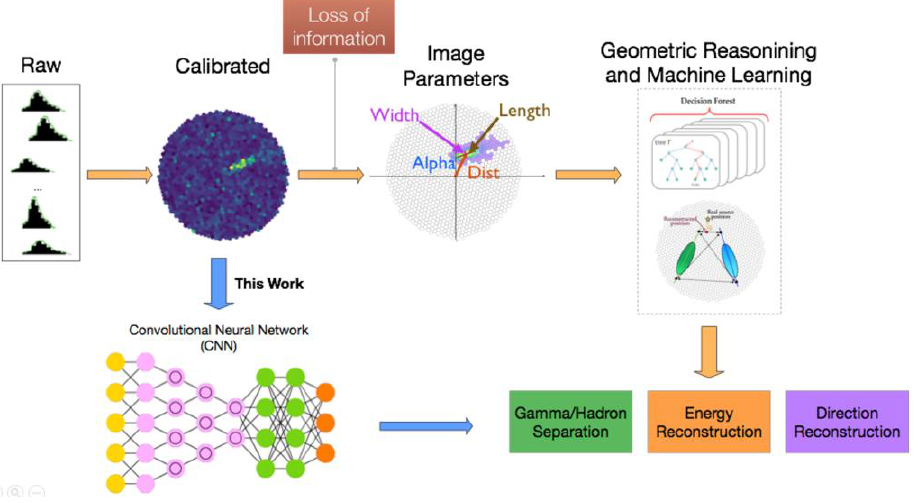
Fig. 2. The new analysis approach based on CNN working directly from the calibrated data compared with the traditional analysis